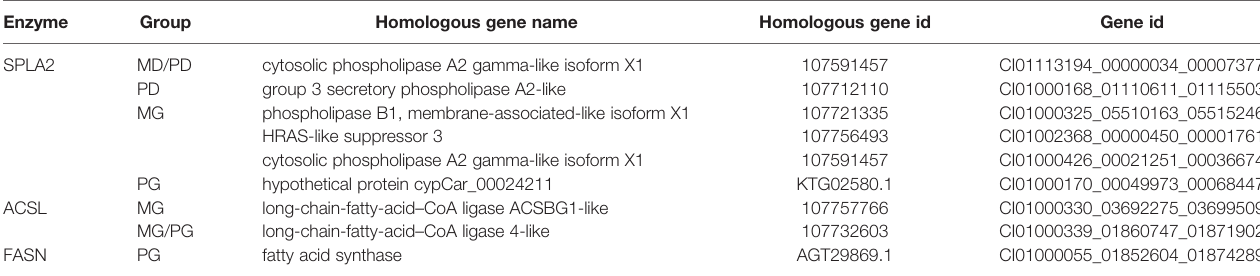
TABLE 1 | Genes to be validated by quantitative reverse transcription PCR.